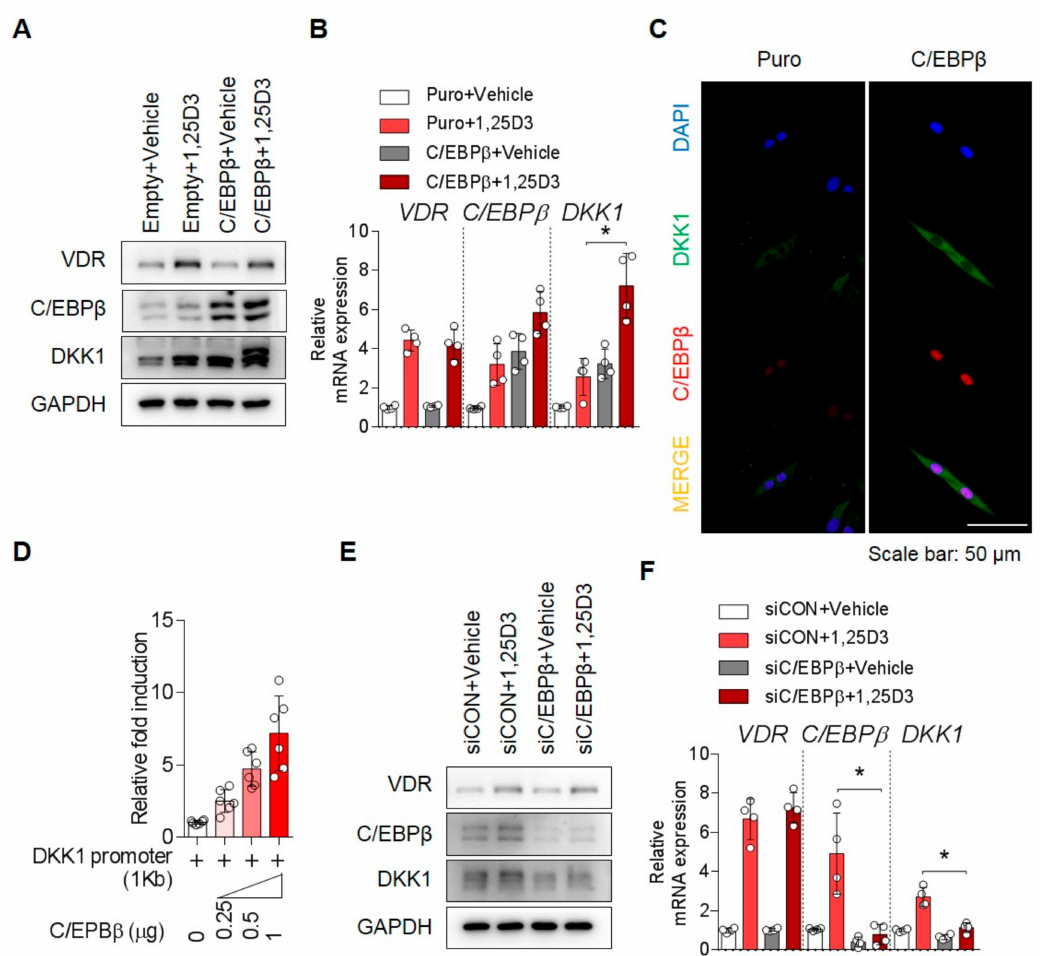
Figure 3. C / EBP β regulates 1,25D3-induced DKK1 expression. Osteoblasts were transfected with empty vector or C / EBP β , incubated for 48 h, and stimulated with 1,25D3 for 24 h. Analysis of ( A ) immunoblotting for protein level and ( B ) qPCR for mRNA level ( n = 4). ( C ) Osteoblasts were transfected with empty vector or C / EBP β for 48 h and transfected cells were stained with anti-DKK1 (green), anti-C / EBP β (red), and DAPI (blue). Scale bar is 50 µ m. ( D ) Osteoblasts were co-transfected with 1 kb DKK1 promoter and C / EBP β in a dose-dependent manner for 48 h and analyzed by luciferase assay ( n = 6). Osteoblasts were transfected with siRNA against control (CON) or C / EBP β , incubated for 48 h, and stimulated with 1,25D3 for 24 h. Analysis of ( E ) immunoblotting for protein level and ( F ) qPCR for mRNA level ( n = 4). Representative data are shown. * p < 0.05; (mean ±